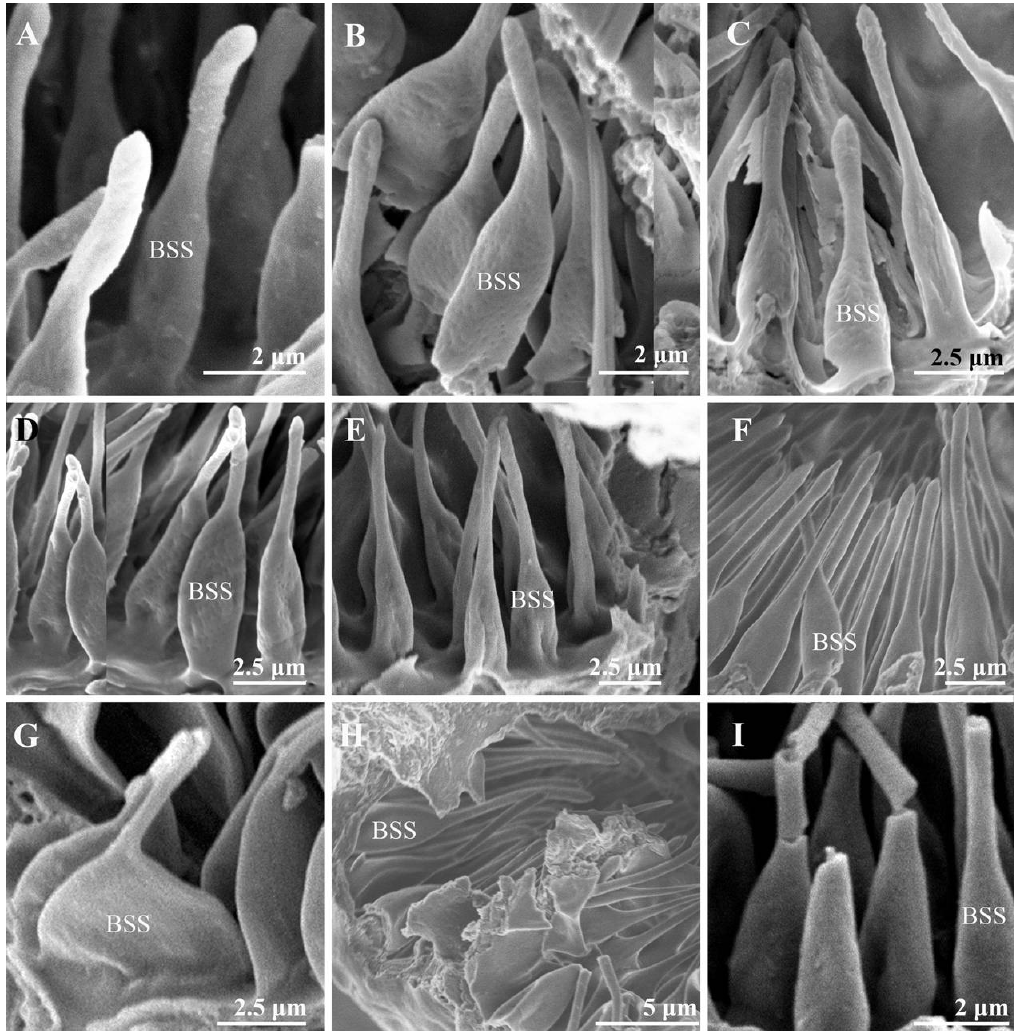
Figure 7. The bottle-shaped sensilla in the sensory pits on the antennal postpedicel of nine male sarcophagid species. ( A ) S . albiceps ; ( B ) S . portschinskyi ; ( C ) S . africa ; ( D ) S . peregrina ; ( E ) W . magnifica ; ( F ) W . bella ; ( G ) A . mihalyii ; ( H ) M . mesomelaena ; ( I ) M . campestris . Abbreviations: BSS (bottle-shaped sensilla).